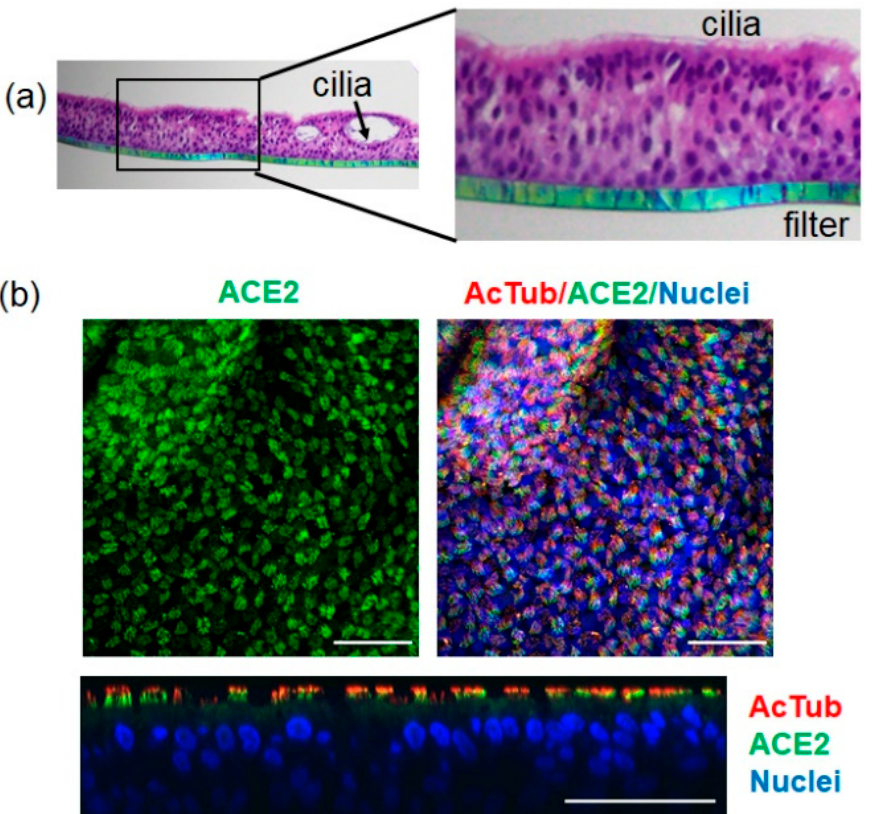
Figure 2. ACE2 is expressed by ALI-HNE. ( a ) Hematoxylin and eosin staining shows apical cilia and deep pseudostratified differentiation. ( b ) Immunofluorescent staining for ACE2 (green) and α -tubulin (red); nuclei are blue (DAPI). Top and orthogonal views are shown. Scale bar 50 µm.